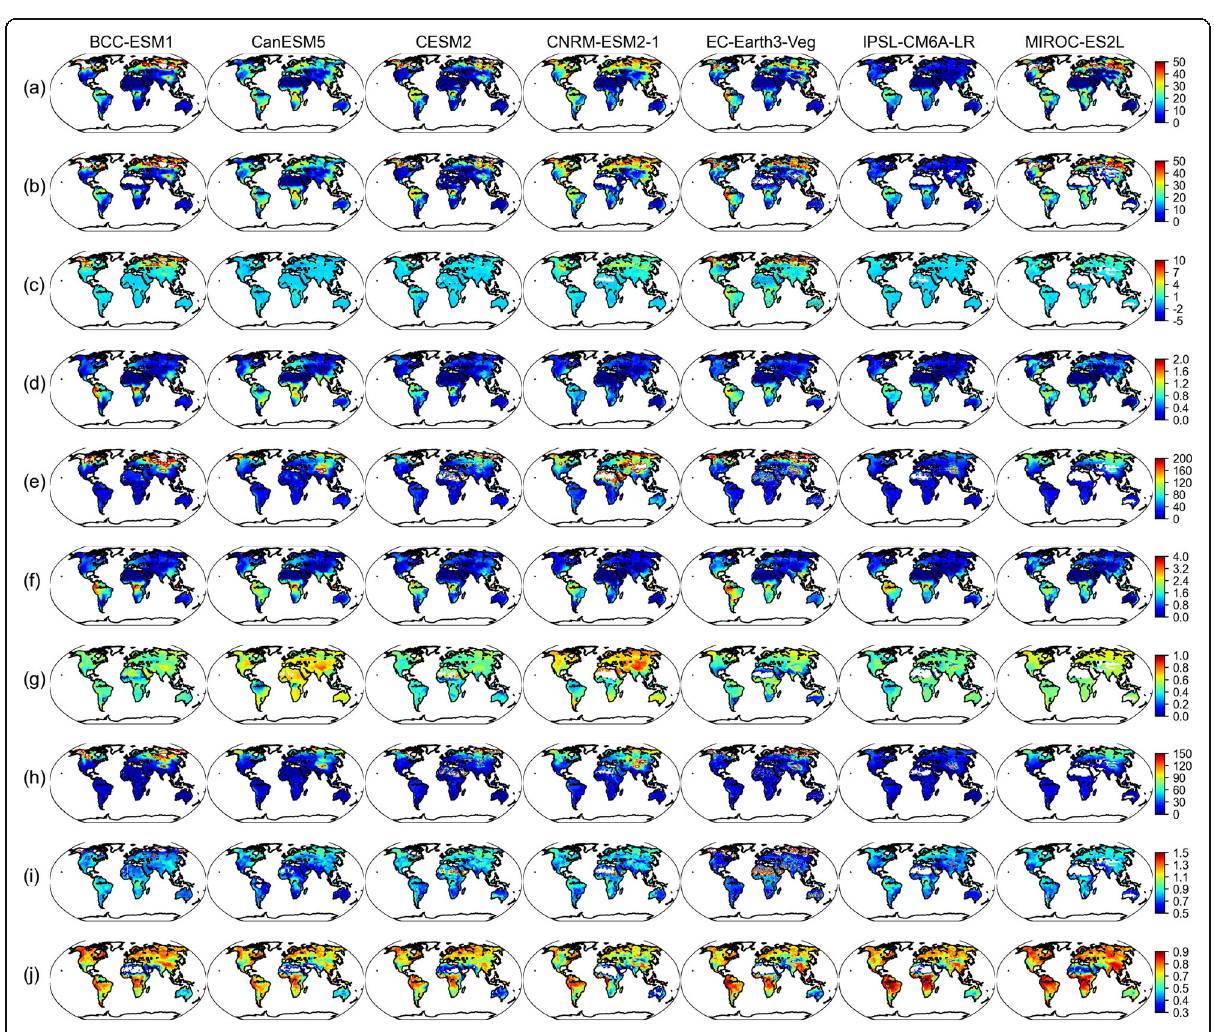
Fig. 7 The global distribution of the mean of carbon storage and its traceable components simulated by seven CMIP6 models for the historical period 1850 – 2014. a Carbon storage (kg C m − 2 ). b Carbon storage capacity (kg C m − 2 ). c Carbon storage potential (kg C m − 2 ). d Net primary (CUE). h Baseline carbon residence time (year). i Temperature scalar. j precipitation